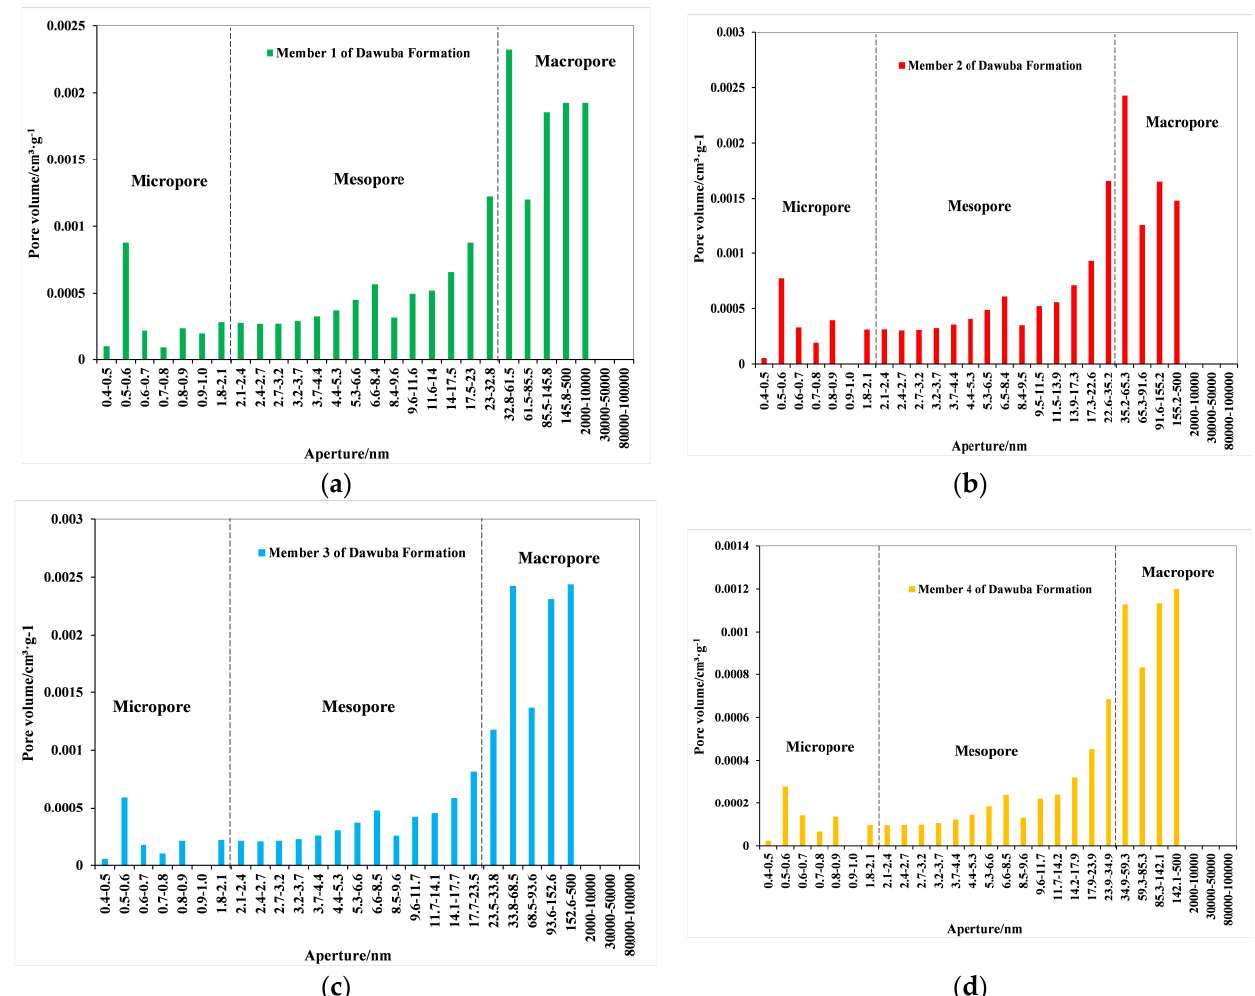
Figure 6. Whole pore size distribution of shale pore volume of the Dawuba Formation in the Qianxi area. ( a ) Member 1 of the Dawuba Formation; ( b ) member 2 of the Dawuba Formation; ( c ) member 3 of the Dawuba Formation; ( d ) member 4 of the Dawuba Formation.